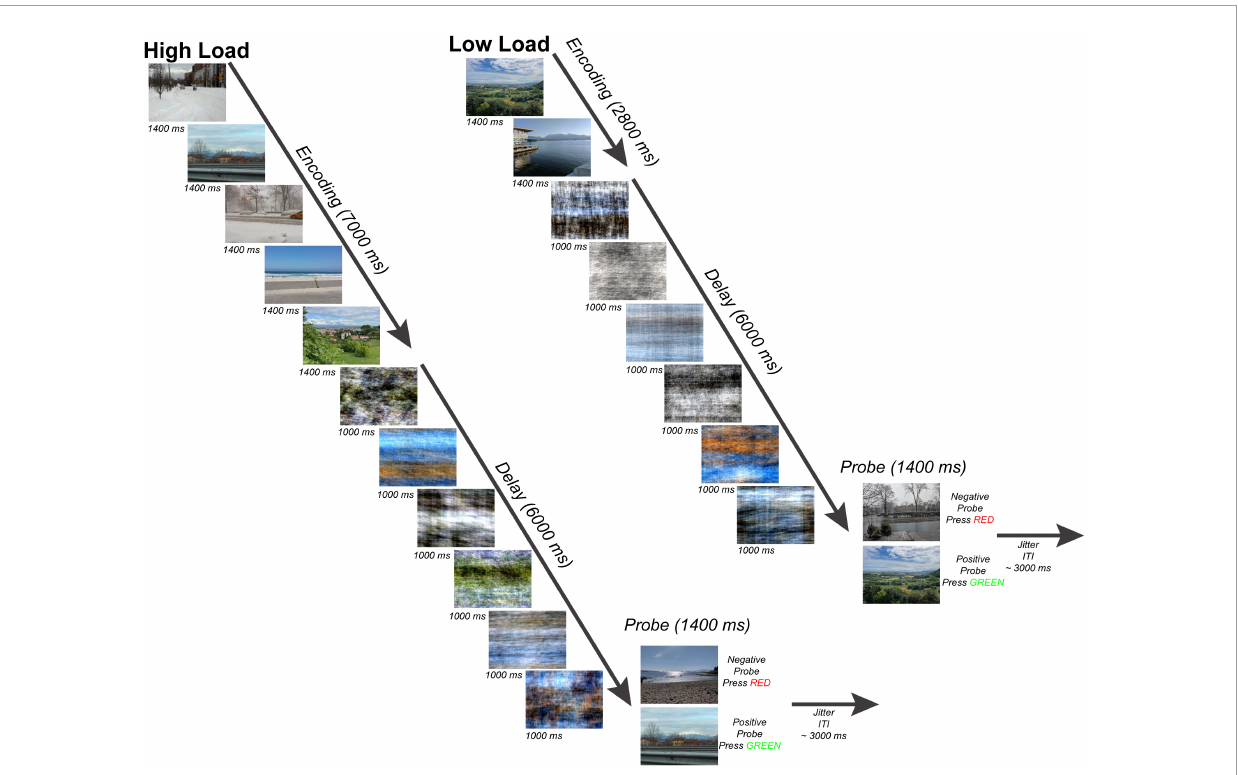
FIGURE1 Working Memory Task. Subjects performed a modified Sternberg task with naturalistic scenes consisting of 50 trials per working memory load. There were two working memory loads: high load-5 images (left) and low load-2 images (right) . Subjects viewed either 5 or 2 sequentially presented images (encoding phase), maintained the scenes across a 6-s length delay period (maintenance phase), and after determined whether a probe scene matched one of the previous images seen during that trial or was a non-match (probe phase). Each trial ended with a jittered inter-trial fixation interval (mean = 3